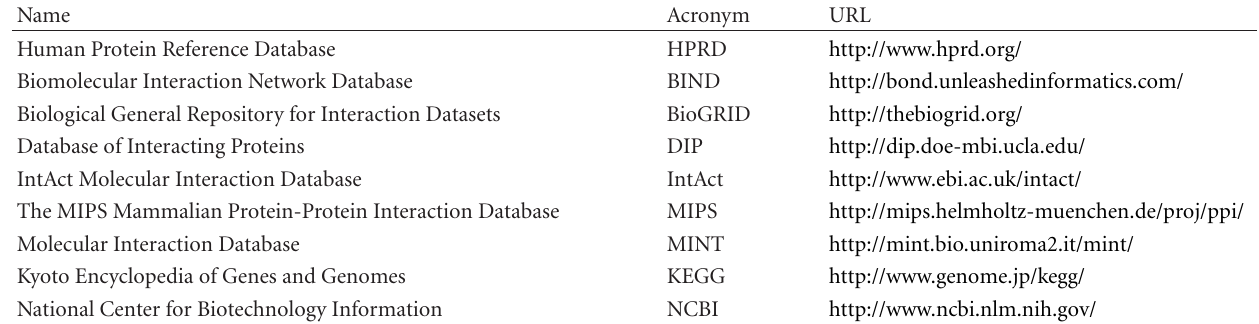
Table 5: Available biological networks sites.